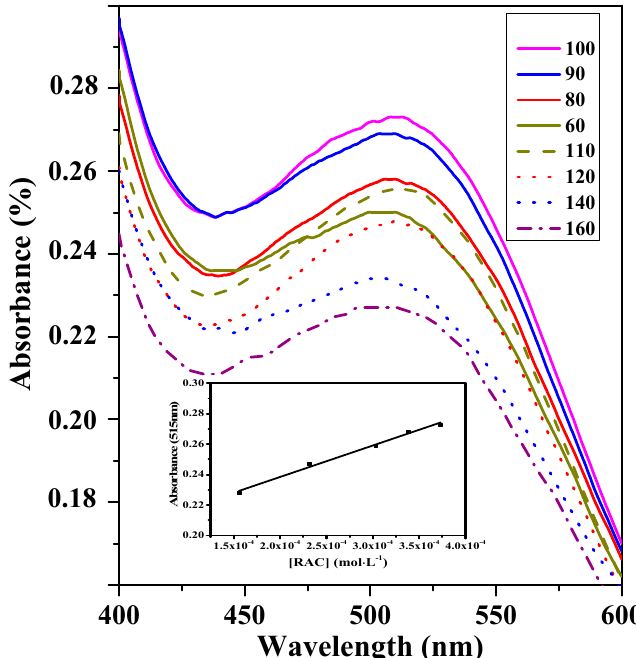
Figure 5. UV − VIS spectra of the amount of RAC with 80 µ L SiW 9 Cu 3 , 160 µ L H 2 O 2 , and reaction time of 25 min. Insert: the plot of absorbance at 515 nm versus the concentration of RAC.